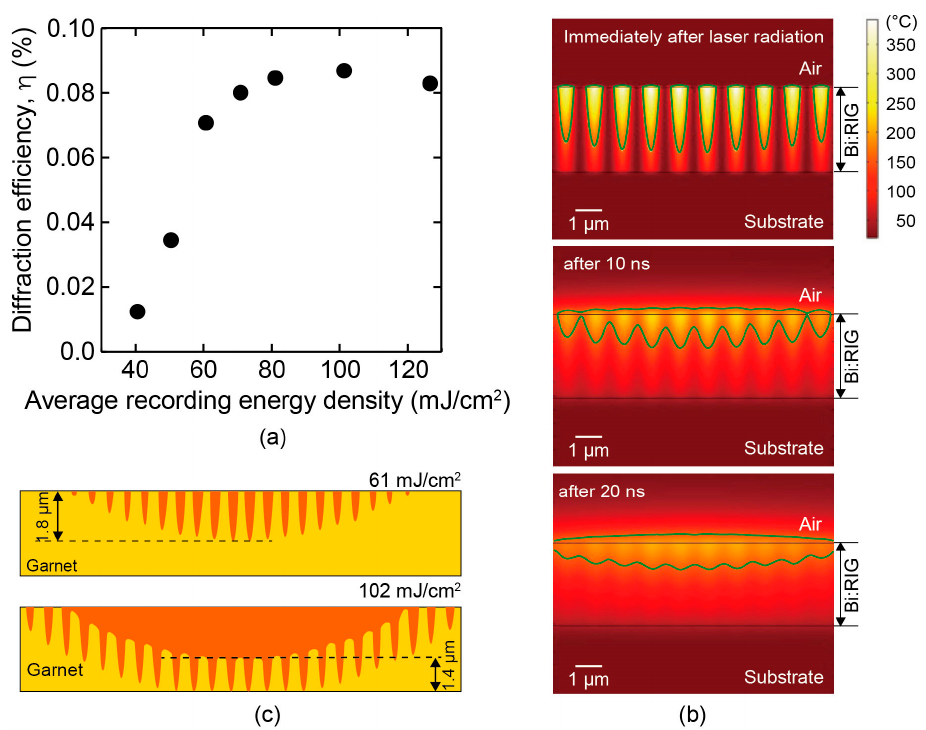
Figure 7. ( a ) Calculated diffraction efficiency at 1500 line-pairs/mm. ( b ) Calculated variation in temperature distribution around the garnet layer after laser irradiation with 81 mJ/cm 2 . The shape of the regions with a temperature higher than the Curie temperature (150 °C) is surrounded by green line. ( c ) Calculated shapes of obtained magnetic fringes in garnet recorded at 61 mJ/cm 2 , and 102 mJ/cm 2 [33].